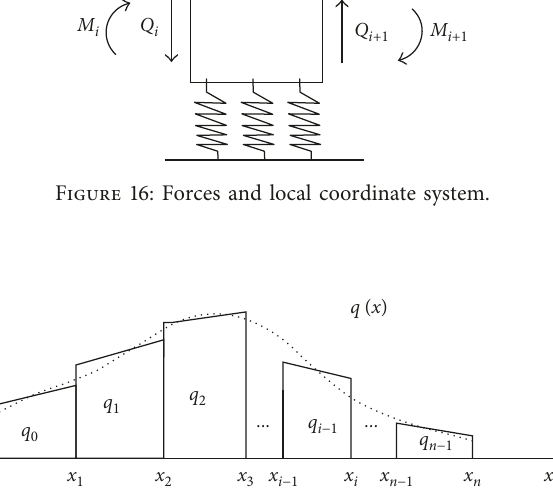
Figure 17: Replacement of variable load with trapezoid